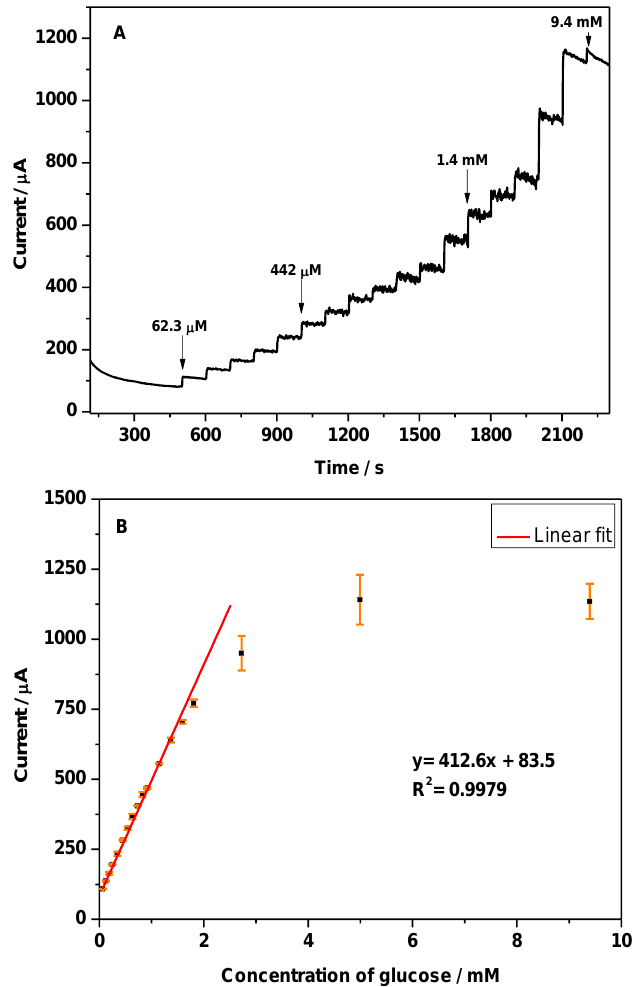
Figure 10. ( A ) Amperometric response of Au-CuNC in 50 mM NaOH to the successful addition of glucose from 62.3 uM to 9.4 mM at the applied potential of +0.7 V vs. Ag/AgCl; ( B ) the corresponding calibration curve.